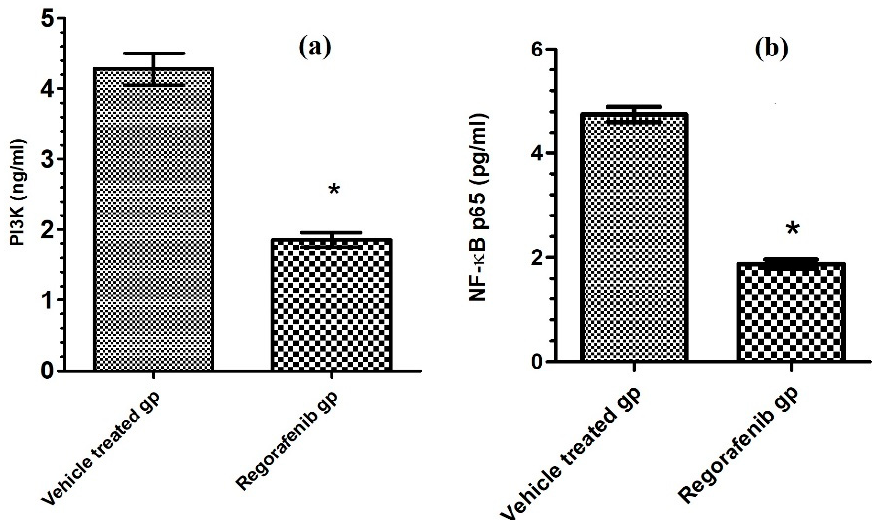
Figure 5. ( a ) PI3K level (ng/mL) in regorafenib-treated and vehicle-treated groups; ( b ) NF- κ B p65 level (pg/mL) in regorafenib-treated and vehicle-treated groups. * Significant from control group at p < 0.05.